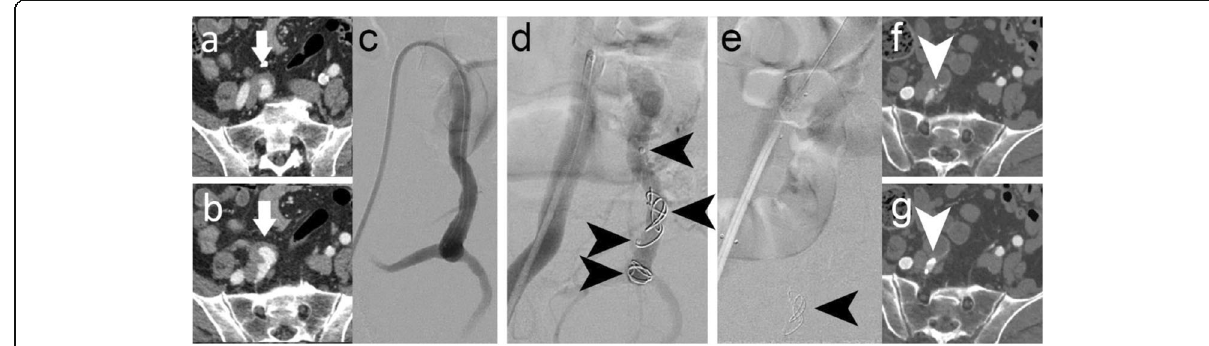
Fig. 2 Case 1. a , b Preprocedural CTA showing a right common iliac artery aneurysm. c Pre-embolisation DSA imaging of the right IIA (and aneurysm). d 8 mm (distal) and 12 mm diameter (proximal) shape memory polymer plugs were sequentially inserted into the 10 mm diameter right IIA. Arrows indicate the anchor coils and proximal markers of the devices, where the anchor coil is distal to the marker. Shape memory polymer is radiolucent but is between the anchor coil and proximal marker. e Post-embolisation DSA imaging where only the proximal device can be seen in this view (arrow). An iliac stent graft was placed after vessel embolisation. f , g Five-week follow-up CTA showed the vessel was